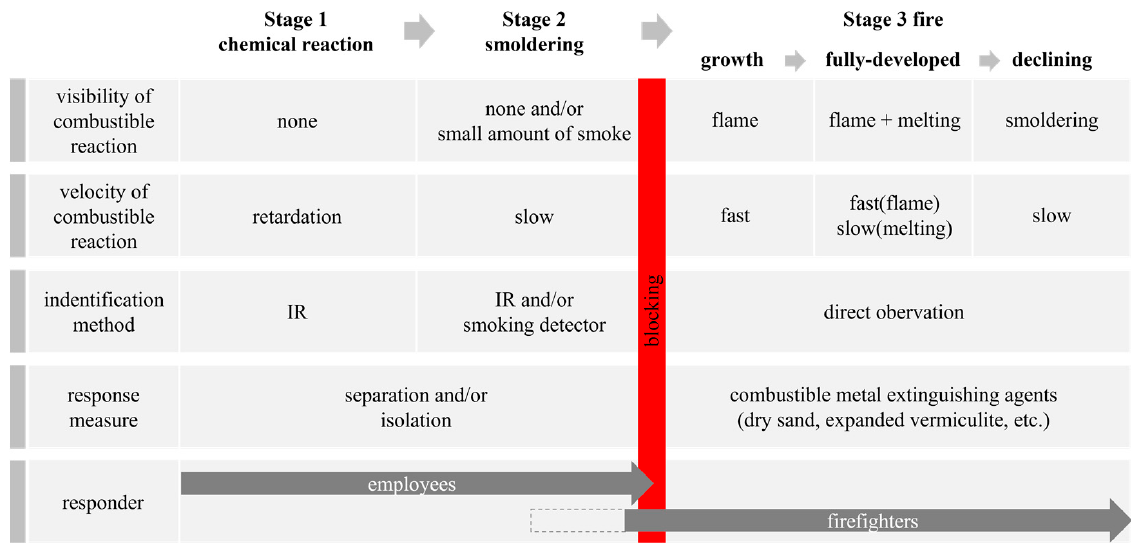
Figure 19. Fire safety mechanism of magnesium dross generated from the recycling process.